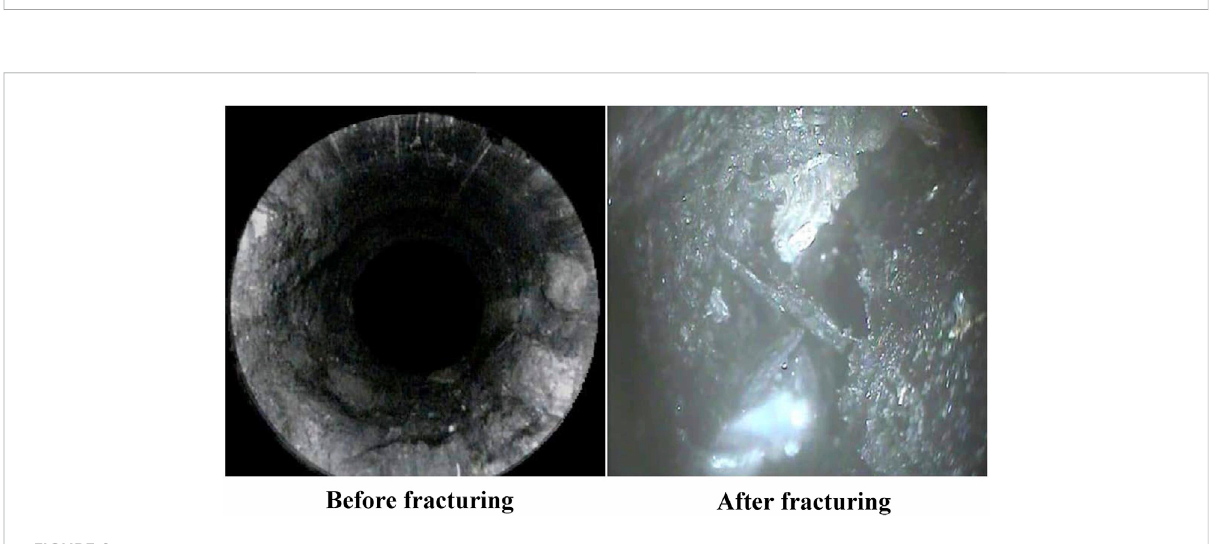
FIGURE 9 Test borehole gas content measurement results comparison